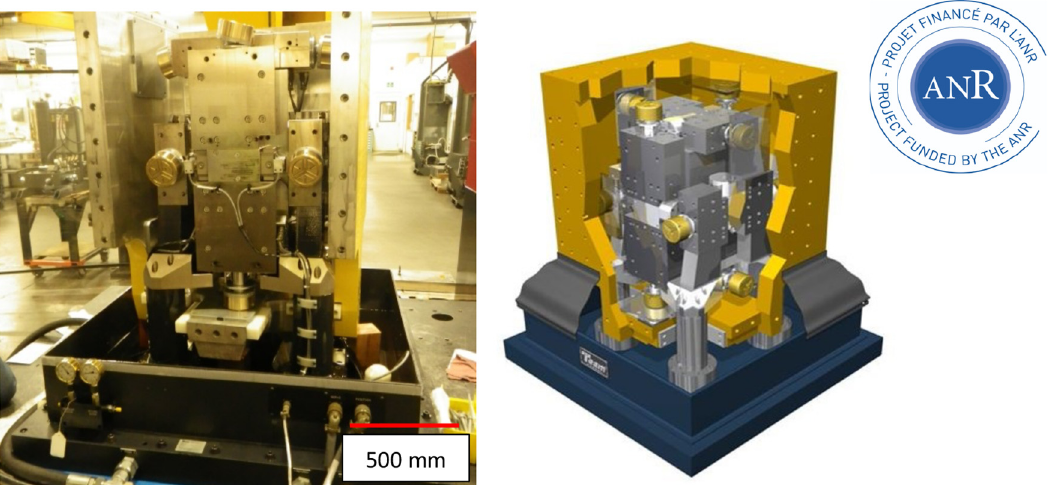
Fig. 24. Illustration of the “ Cube ” with the cylinders mounted on hydraulic bearings allowing movement and the application of mechanical forces.